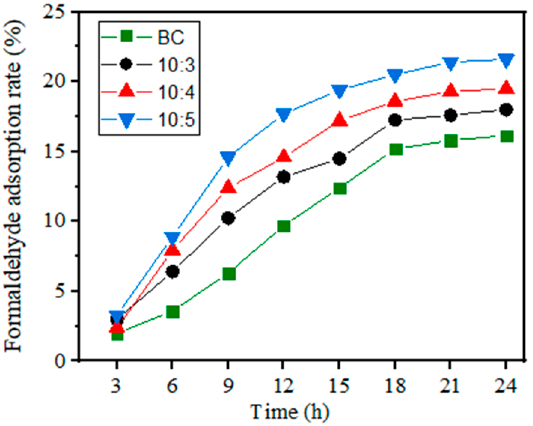
Figure 8. Formaldehyde adsorption rate curves of the composites with different